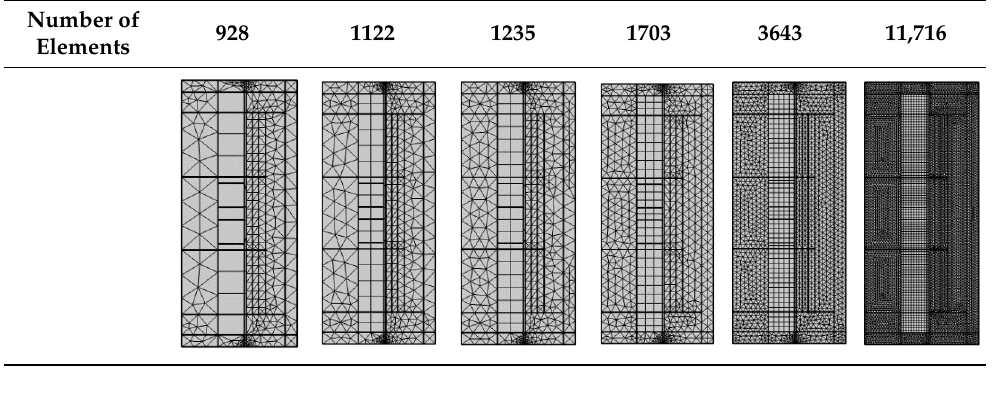
Table 3. Discretized geometry and corresponding number of assessed finite elements.